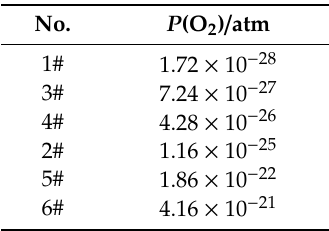
Table 2. Oxygen partial pressures at different annealing conditions.